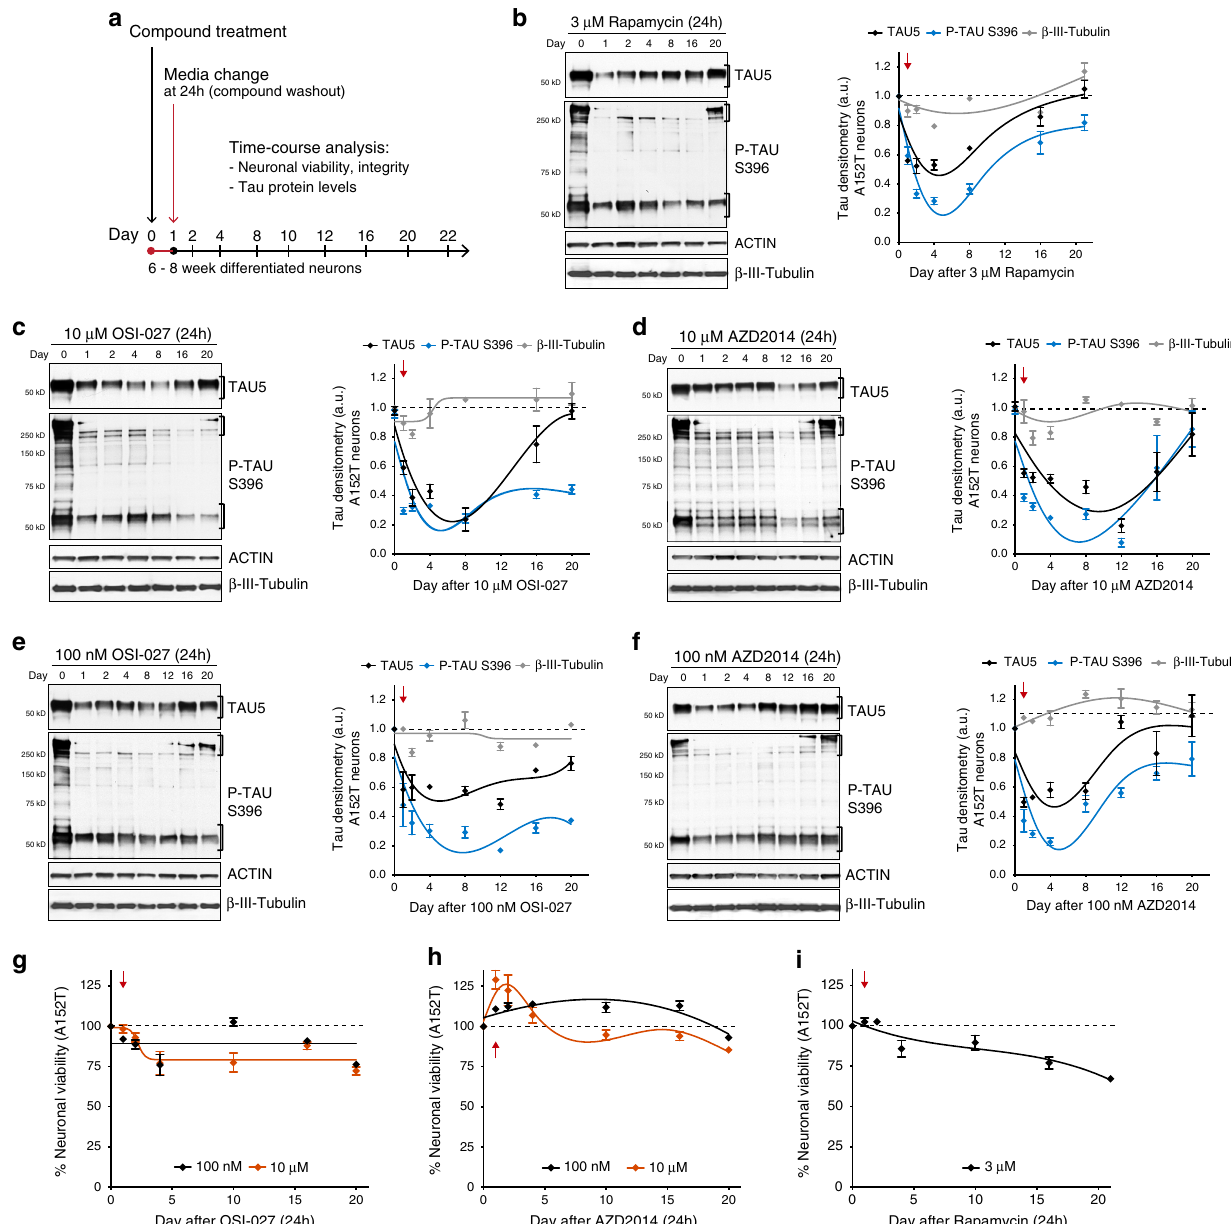
Fig. 7 Single-dose mTORi has sustained effect on tau phenotypes. a Assay to measure effect of mTORi 24h-treatment on tau levels and neuronal viability over a time-course of 20 days. b – i A152T neurons (6-week differentiated FTD19-L5-RC6) were treated with rapamycin, OSI-027 or AZD2014 for 24 h, followed by compound washout (red arrow). b – f Total tau (TAU5), P-tau S396 and the neuronal microtubule marker β -III-tubulin were measured by western blot over a period of 20 days post treatment. Representative blots are shown, and graph data points represent mean protein densitometry (bands within brackets) ± SEM for n = 3 biological replicates. Dotted lines correspond to vehicle-treated protein levels. g – i Time-course analysis of effect on neuronal viability. Data points represent average % viability relative to vehicle ± SEM for n = 3 biological replicates. Source data are provided as a Source Data fi